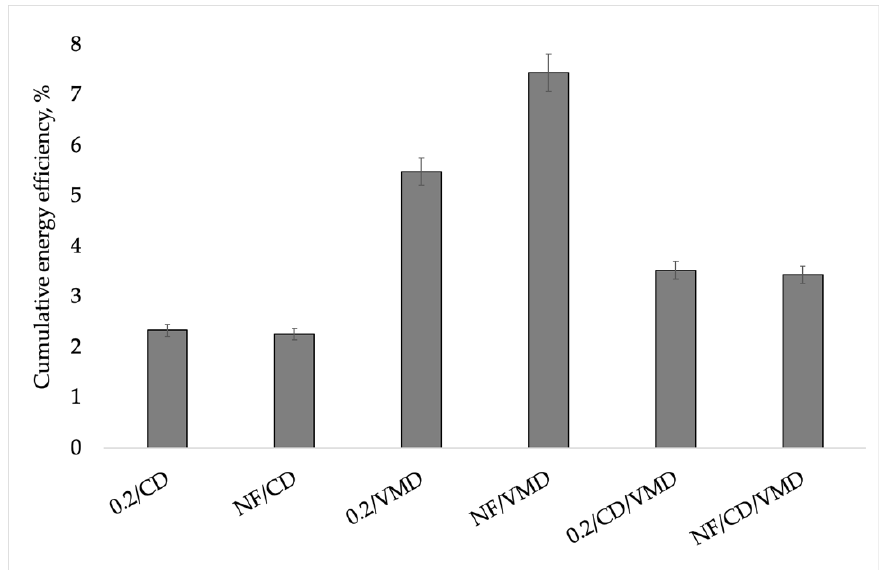
Figure 4. Cumulative energy efficiency during drying using different methods.